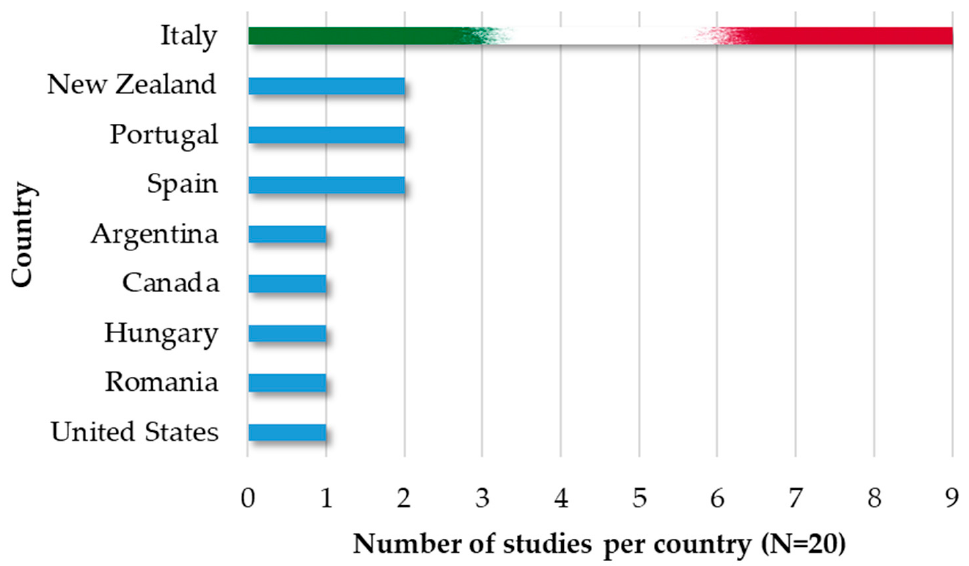
Figure 2. Distribution of studies on wine WF assessment by country.